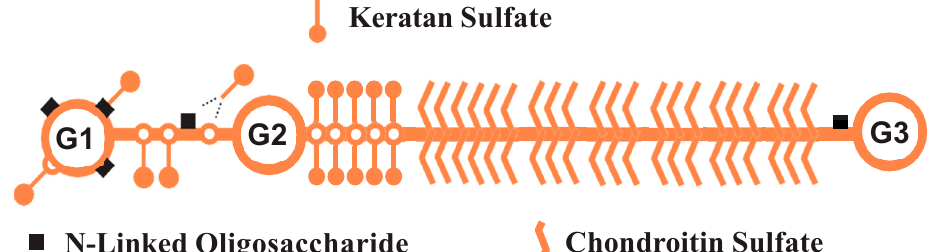
Figure 1. Schematic structure of bovine aggrecan. The aggrecan core protein comprises three globular domains (G1, G2 and G3) with an extended interglobular domain (IgD) between G1 and G2, and a larger extended region between G2 and G3. Keratan sulfate is substituted on the core protein primarily in a KS-rich region near G2. KS chains are also found on the G1 domain and IgD. Chondroitin sulfate chains are substituted throughout the extended region between the KS-rich region and G3. N-glycans are found on G1 and the IgD, and near G3.